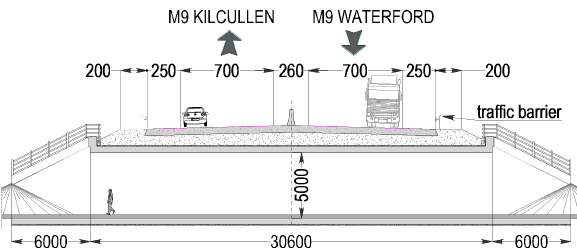
Figure 1: Longitudinal section of bridge